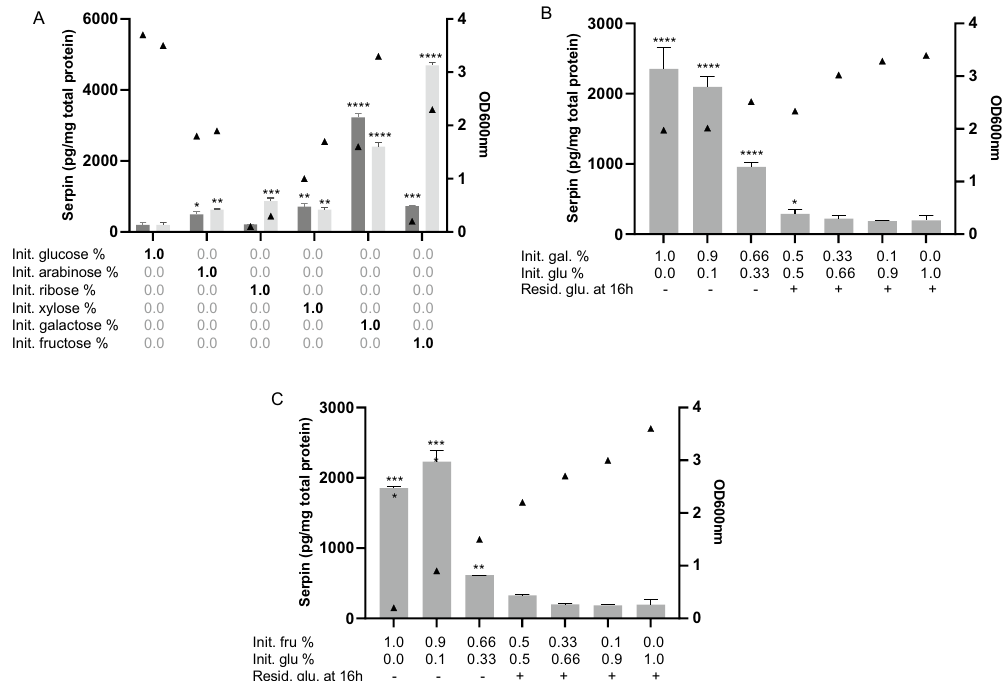
Figure 3. Serpin concentration measured in extracts of B. longum NCC 2705 grown for 24 (dark grey) and 48 h (light grey) on different monosaccharides ( A ). Serpin concentration measured in B. longum NCC 2705 grown for 16 h on different concentrations of glucose and galactose ( B ) and glucose and fructose ( C ). Bars represent serpin quantity normalized by total protein content, means and standard deviations are depicted. Initial carbohydrate concentrations are depicted. Presence of residual glucose in the culture supernatant after 16 h of incubation is indicated (+ /−) ( B , C ). Triangles represent growth at the end of the incubation, measured by optical density at 600 nm. P -values represent statistical difference to the glucose control group. **** p < 0.0001; *** p < 0.001; ** p < 0.01; * p <